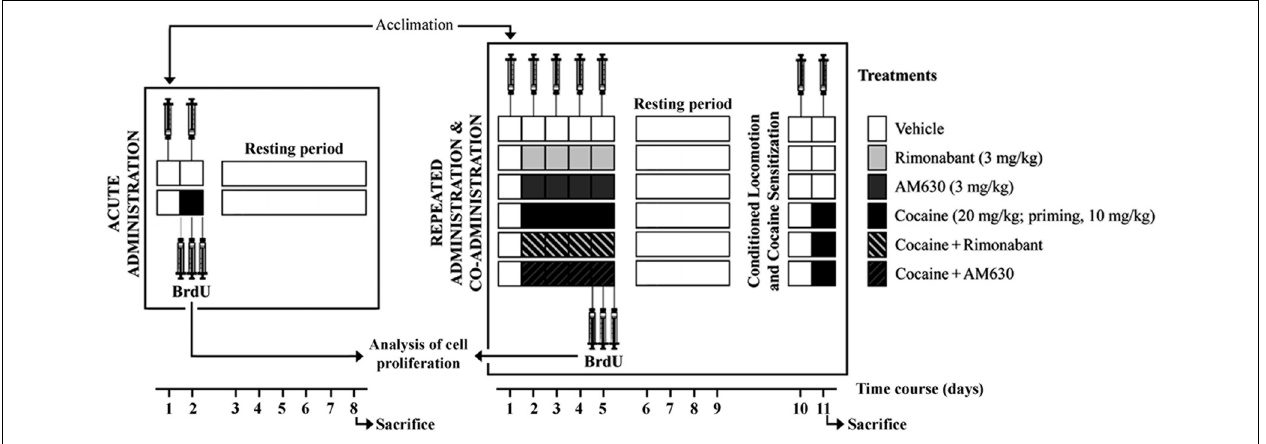
and cocaine-induced sensitization with priming doses of cocaine (10 mg/kg) were evaluated. After treatments, all animals were tested daily in the OF, and locomotion was measured for 20 min. Three doses of BrdU were administered to each animal prior to, immediately after and 8 h after the last cocaine injection for the analyses of brain cell